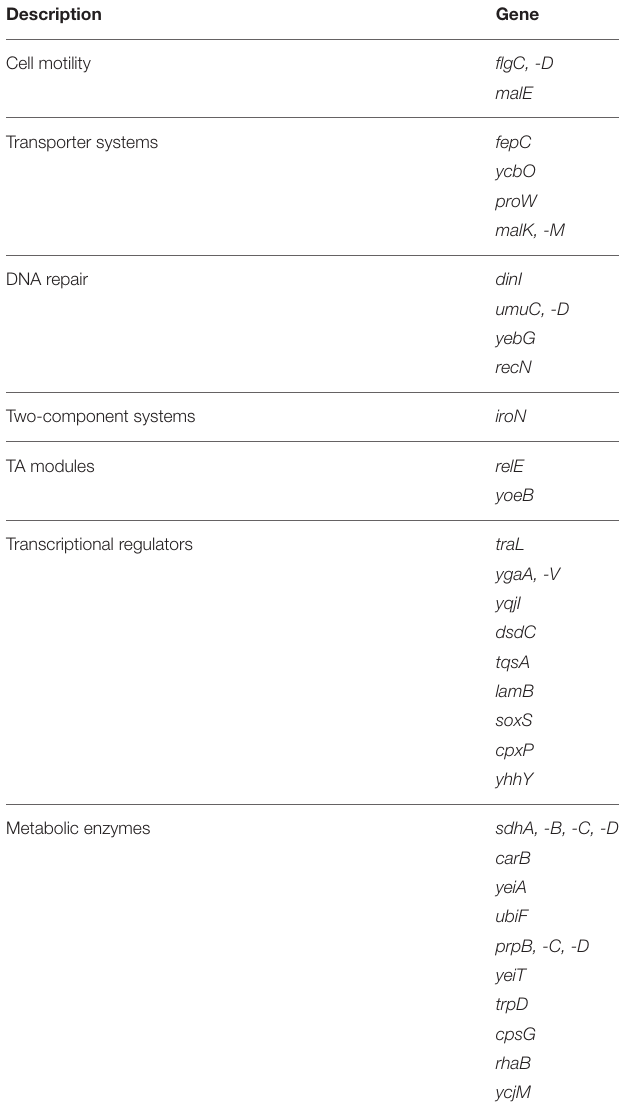
TABLE 1 | Genes upregulated by ≥ 2-fold in the ryhB -knockout mutant relative to the parent strain UTI89 according to RNA-Seq analysis. Description